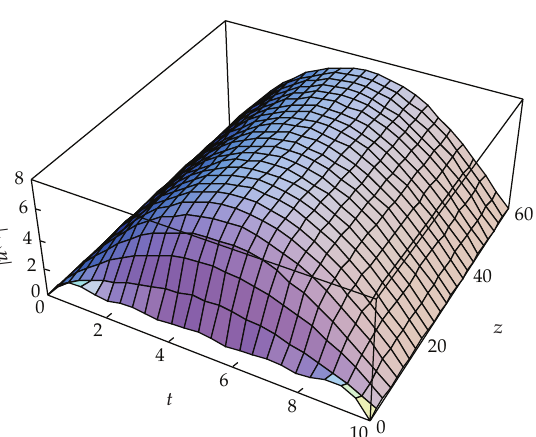
Figure 22: The zero-order approximation of | u (cid:3) 0 (cid:4) | at α (cid:8) 1, T (cid:8) 10, γ (cid:8) 02 with considering only one term in the series (cid:3) M (cid:8) 1 (cid:4) .